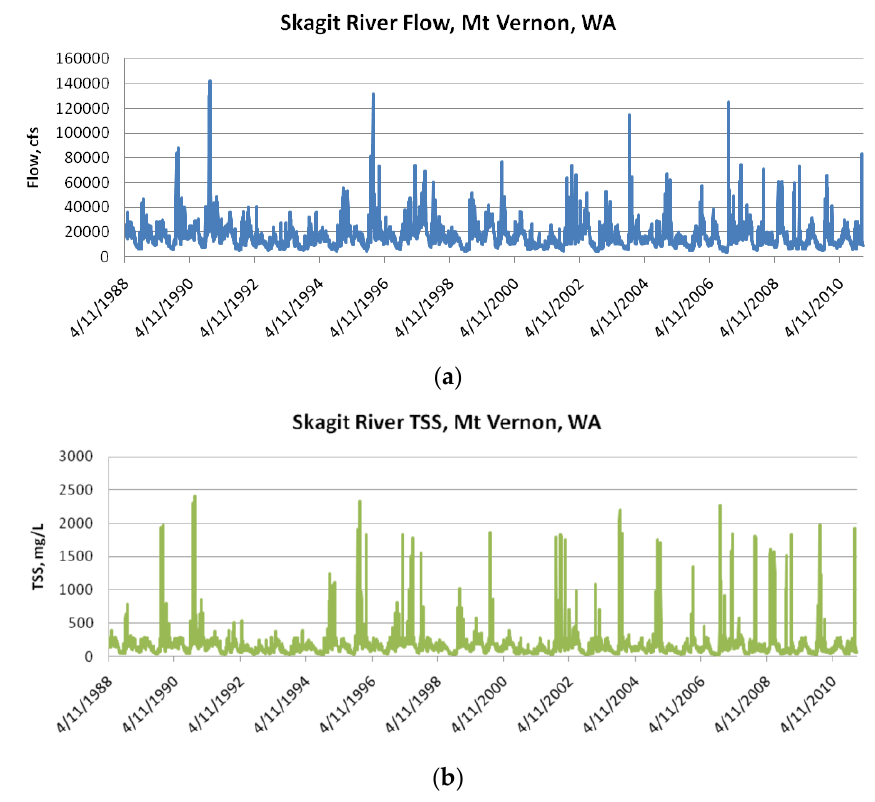
Figure 4. Skagit River daily ( a ) average flow and ( b ) estimated TSS at Mt. Vernon, Washington.